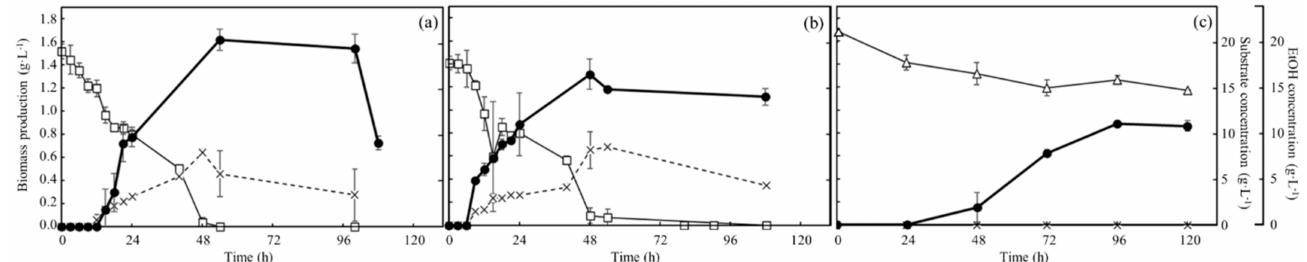
Figure 3. Time-course profiles of biomass production, carbon source consumption, and ethanol production of wildtype and no.7 in each medium under aerobic conditions. The figures show the profiles of ( a ) wildtype in SD, ( b ) no.7 in SD, and ( c ) no.7 in YNBG, under aerobic conditions. Symbols of the closed circle bold line, open square thin line, open triangle thin line, and cross-broken line correspond to biomass production (g · L − 1 ), glucose concentration (g · L − 1 ), glycerol concentration (g · L − 1 ), and ethanol concentration (g · L − 1 ), respectively. Glucose and glycerol concentrations are summarized as the substrate concentration in the figures. The growth profile depending on values of OD 600 in YNBG was used as the secondary evaluation, and the values were converted into biomass production with the calibration